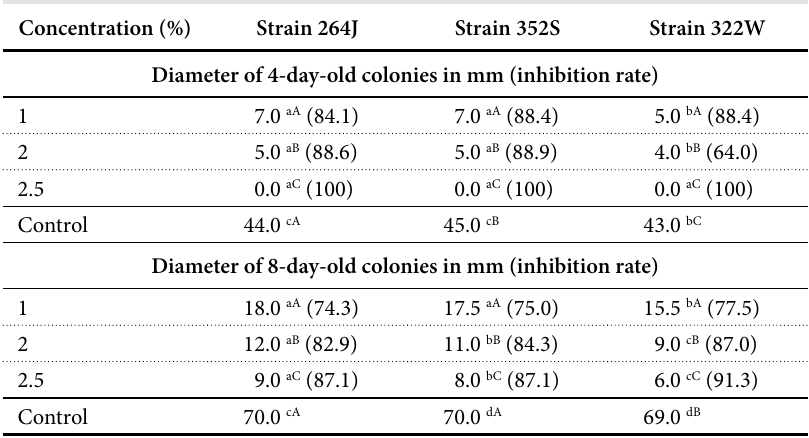
Tab. 7 Influence of Beta-Chikol on the growth of Diaporthe eres